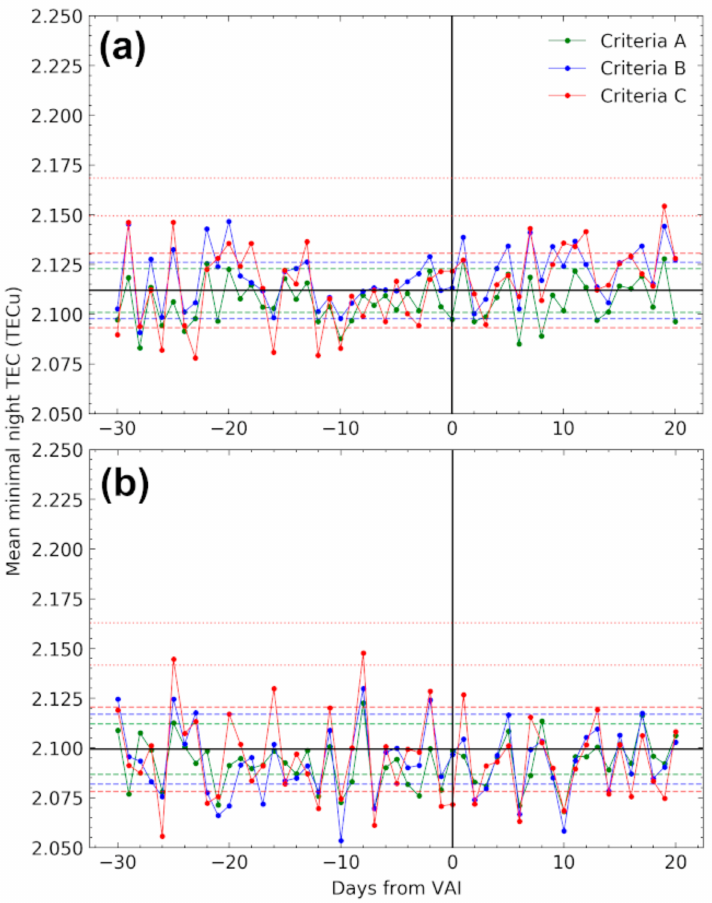
Figure 7. Mean values of minimum night-time TEC at IGS San Fernando ( a ) and Nicosia ( b ).